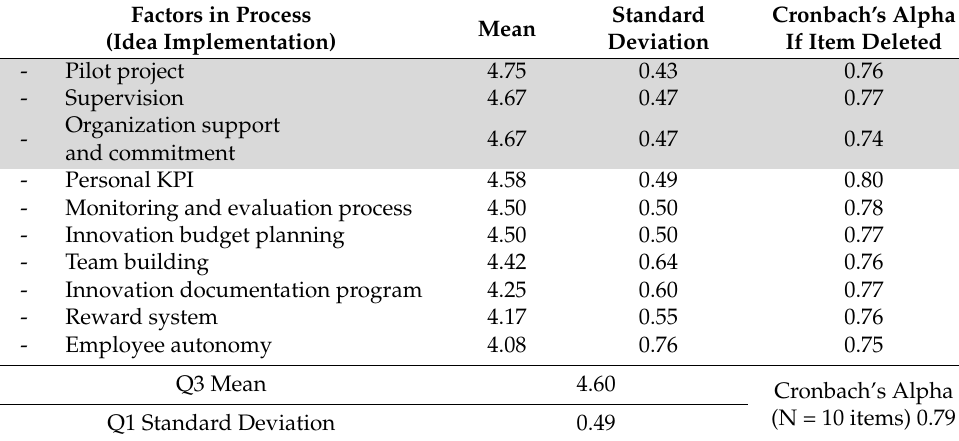
Table 6. Calculation of Q3 mean and Q1 standard deviation of the idea implementation process indicator factors.